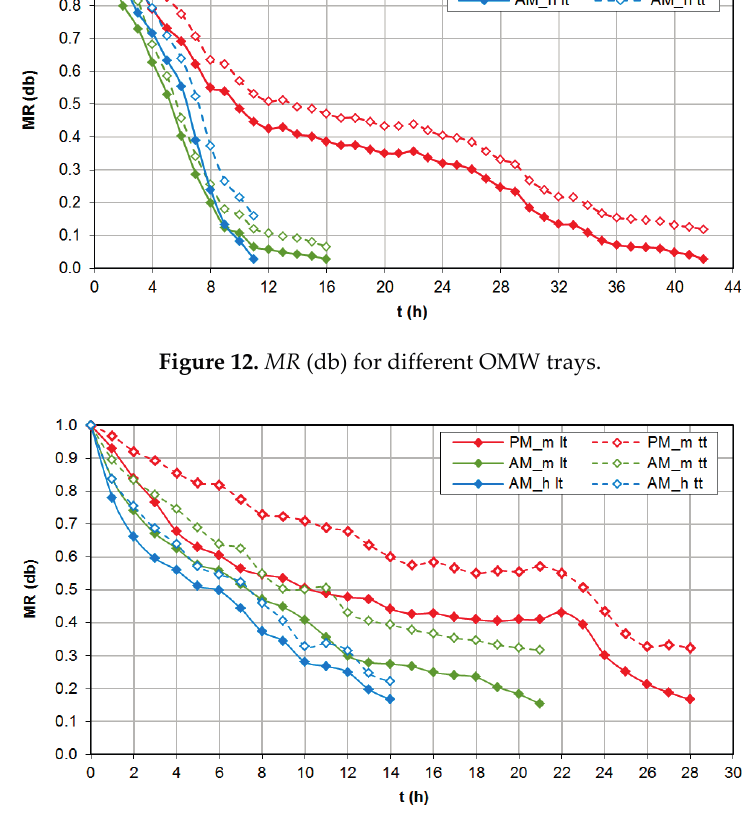
Figure 13. MR (db) for different SLG